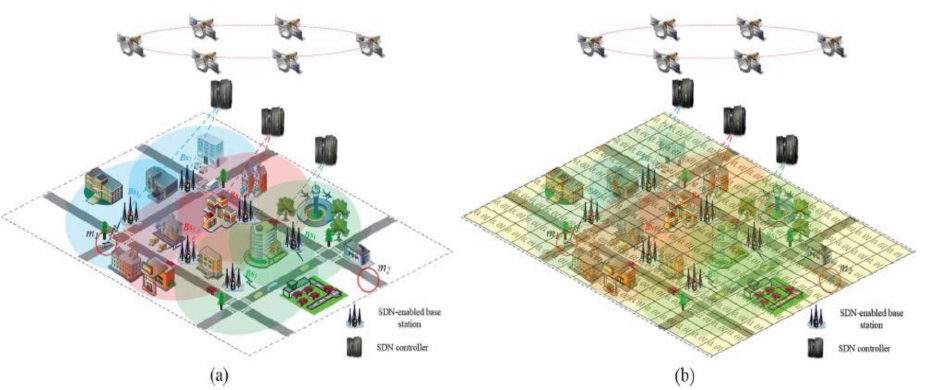
Figure 8. SDN-enabled smart city and the grid-square embedded model [26]: ( a ) SDN-enabled SC with distributed path planning management; ( b ) Grid-based network